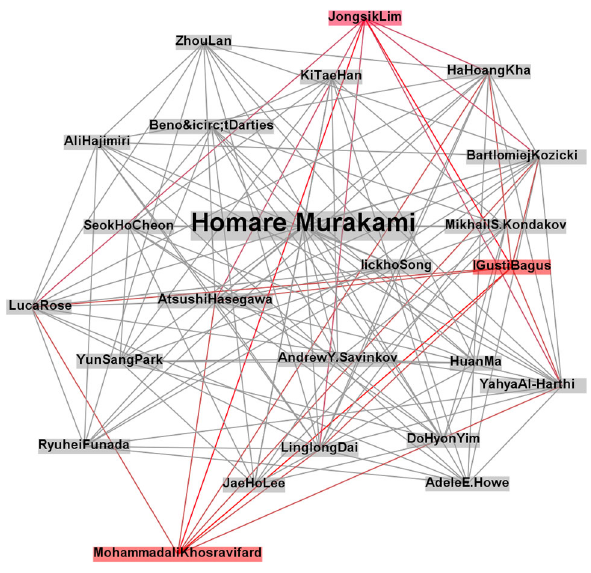
Fig. 11 The case study on 9-core-truss of ‘‘Homare